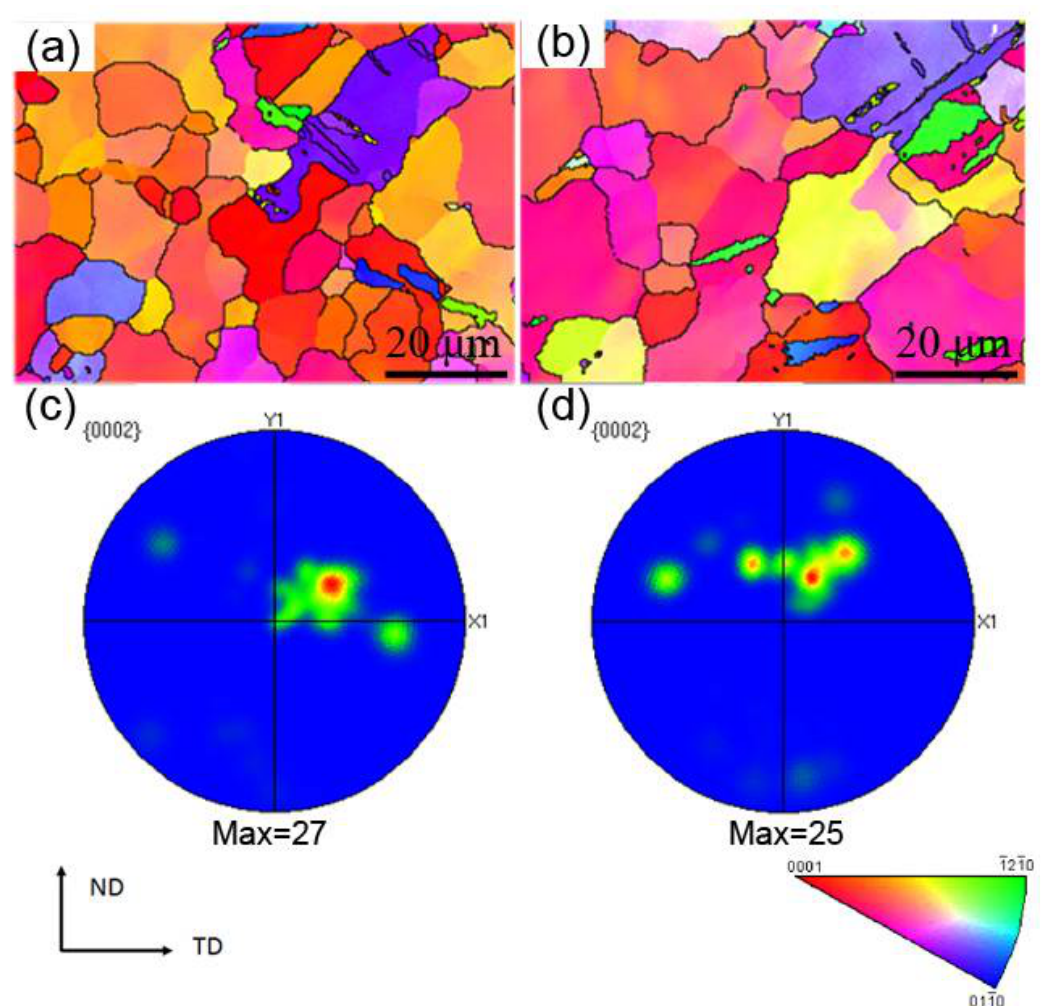
Figure 7. ( a , b ) Inverse pole figure (IPF) orientation maps, ( c , d ) {0002} pole figures, respectively, showing the corresponding microstructure and texture at locations A and B labelled in Figure 2a after Erichsen cupping test at a punching speed of 0.1 mm/min.